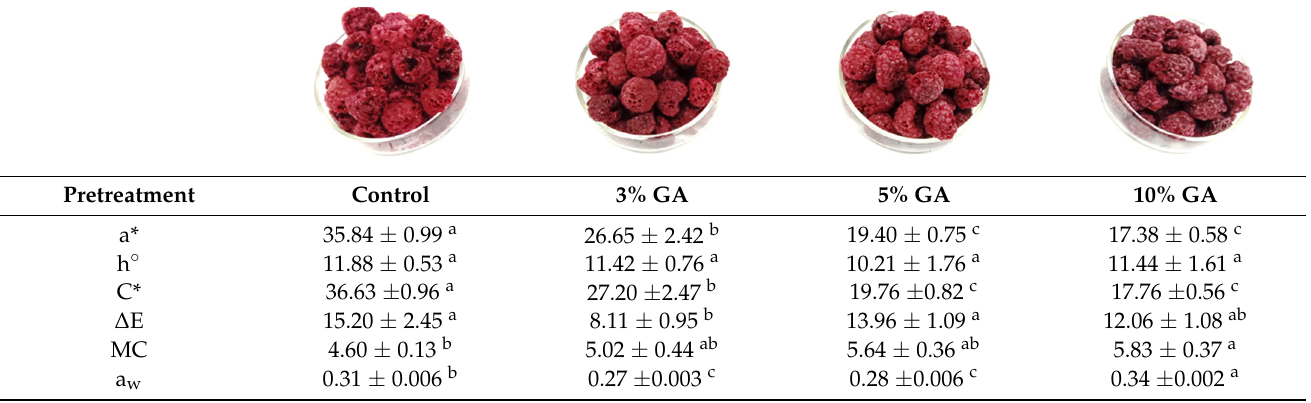
Table 1. Colour attributes, moisture content, and water activity of the control, GA-pretreated and oven-dried (60 °C for 18–24 h) raspberries.